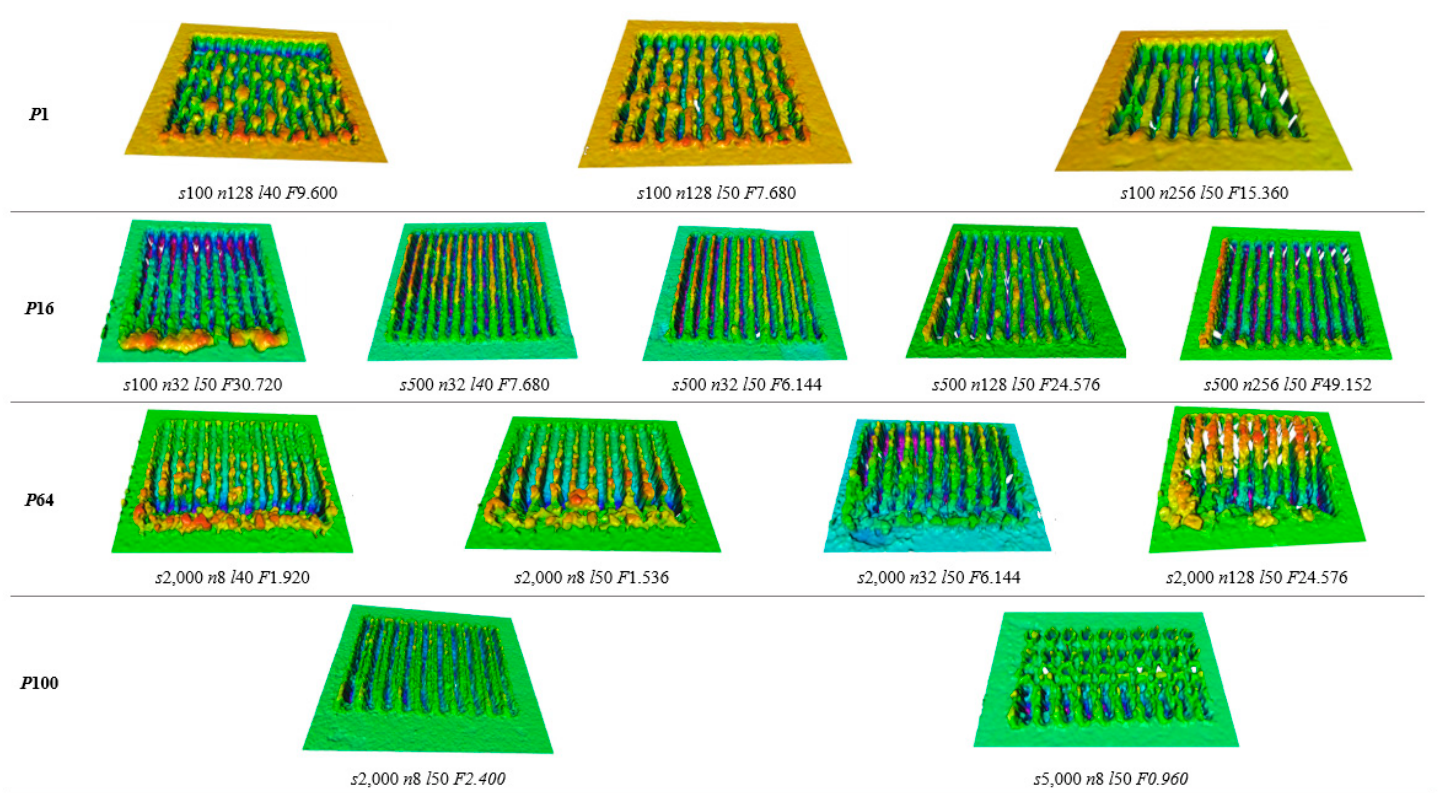
Figure 6. Three-dimensional optical profilometry images of the most promising textures ( P = laser power in %, s = scanning speed in mm/s, n = number of passes, l = line spacing in µm, and F = laser energy fluence in J/mm 2 ).